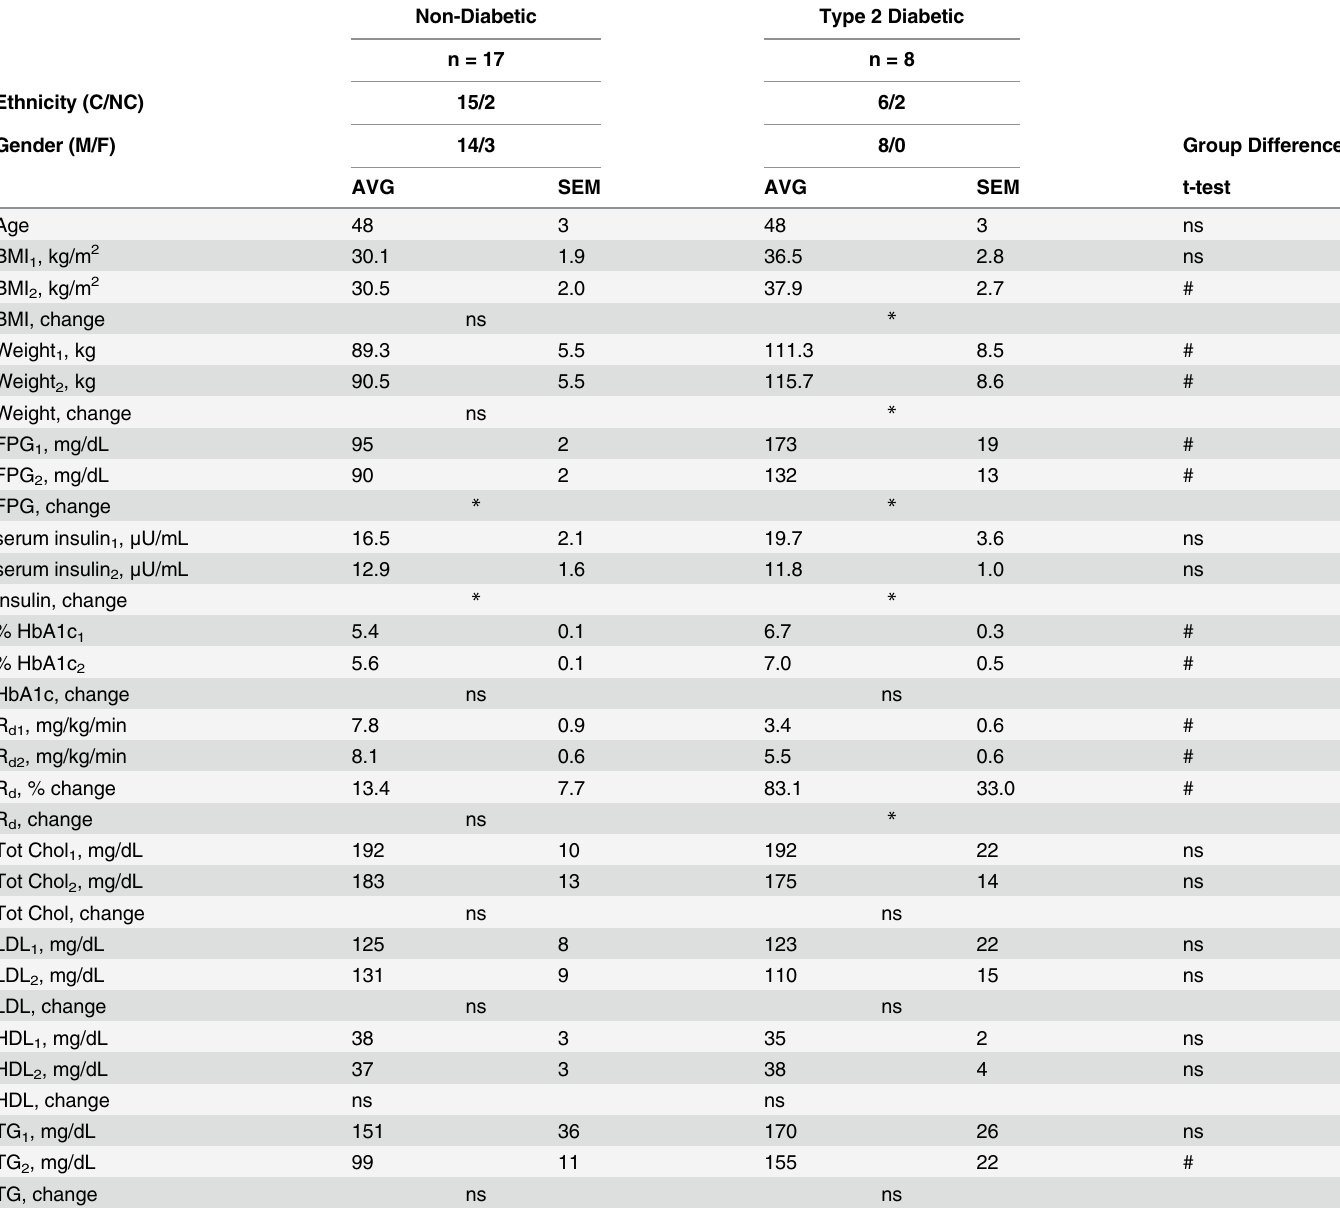
Table 1. Clinical characteristics of adults before and after treatment with 45 mg/day pioglitazone (PIO) for 12 weeks (Cohort